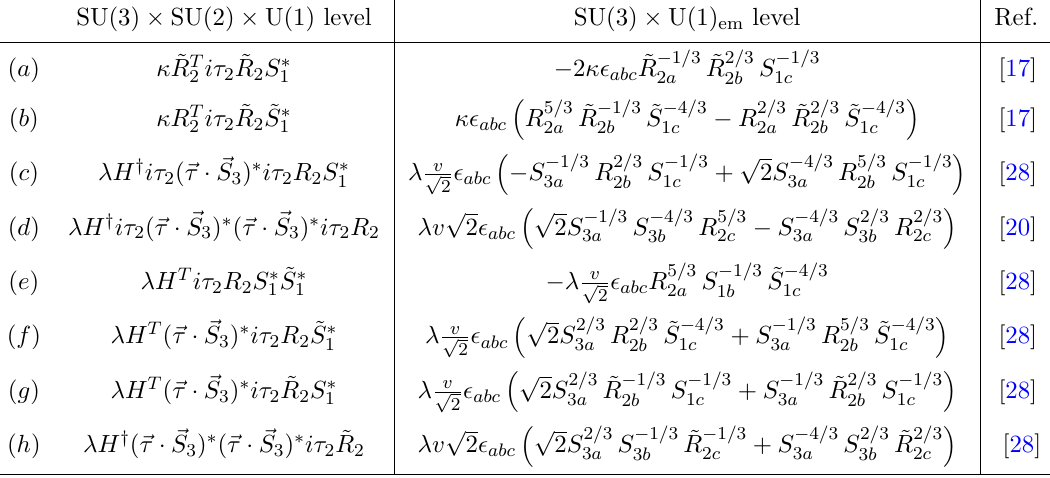
Table 2 . Cubic and quartic leptoquark multiplet contractions at the SU(3) × SU(2) × U(1) level and the associated triple-leptoquark interactions at the SU(3) × U(1) em